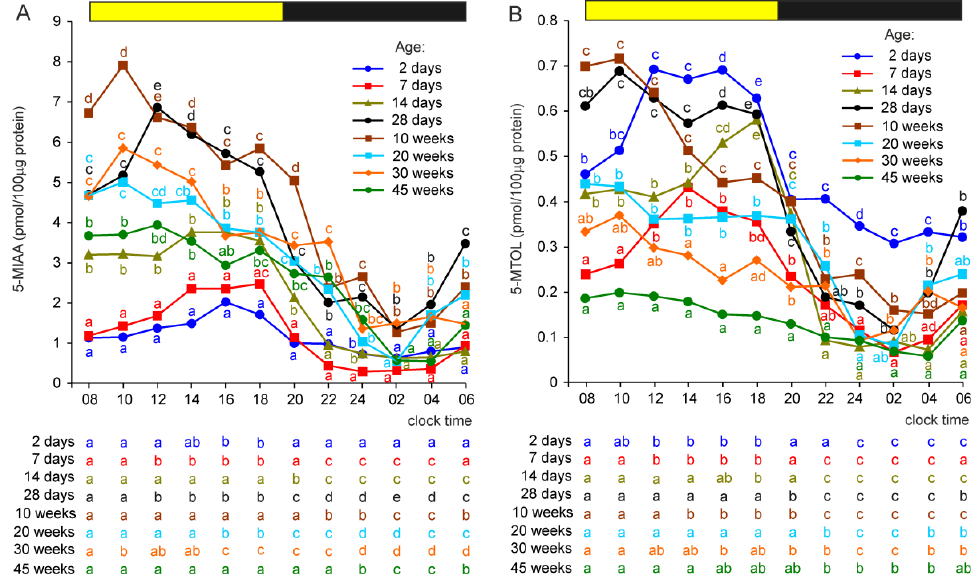
Figure 6. Concentrations (means) of 5-methoxyindole acetic acid, 5-MIAA ( A ), and 5-methoxytryptophol, 5-MTOL ( B ), in the pineal organs of turkeys at the ages of 2, 7, 14, 28 days and 10, 20, 30, 45 weeks. The horizontal bar represents the periods of light and dark phases of the daily cycle. The letters on the charts show differences between age groups at each time-point in Duncan’s test. The letters below the charts show differences between time-points within a group in Duncan’s test. The same letters indicate means which are not significantly different.